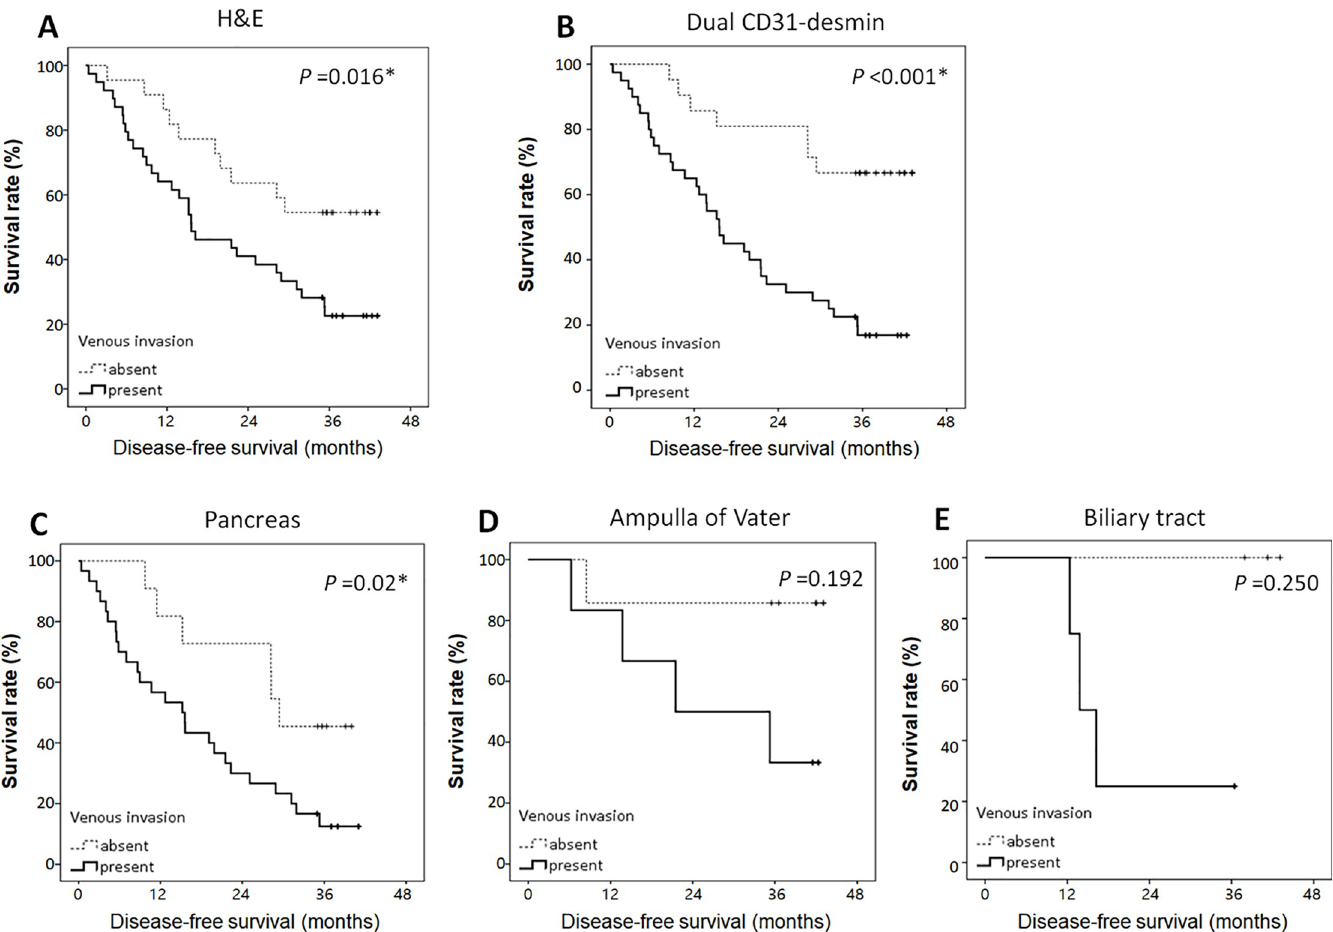
Fig 8. Kaplan–Meier survival analyses of disease-free survival of pancreatobiliary tract cancers based on VI status. (A) Patients with pancreatobiliary tract cancer and venous invasion detected by H&E staining have significantly worse disease-free survival (3-year survival rate, 23%) than those without VI (46%; P = 0.016). (B) Patients with pancreatobiliary tract cancer and venous invasion detected by dual CD31–desmin immunolabeling have significantly worse disease-free survival (3-year survival rate, 18%) than those without venous invasion (67%; P < 0.001). (C) Patients with pancreas cancer and venous invasion have significantly shorter disease-free survival (3-year survival rate, 14%) than those without venous invasion (42%; P = 0.02) by dual CD31–desmin immunolabeling. Patients with (D) ampulla of Vater and (E) biliary tract cancers and venous invasion had a tendency of shorter disease-free survival than those without venous invasion (ampulla of Vater cancer, 3-year survival rate, 34% vs 86%, P = 0.192; biliary tract cancer, 100% vs 25%, P = 0.250) by dual CD31–desmin immunolabeling.